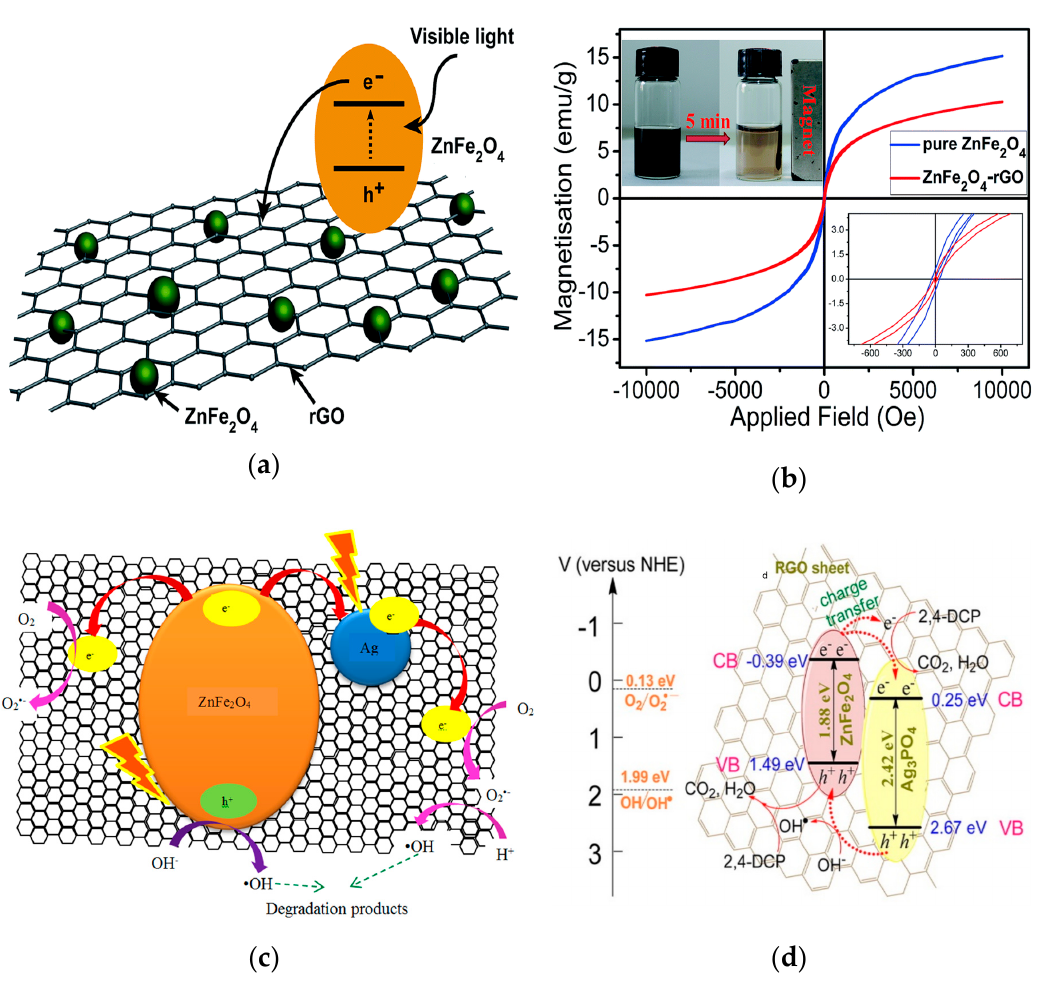
Figure 6. ( a ) Charge transfer route in RGO/ZnFe 2 O 4 ; ( b ) magnetisation curves for pure ZnFe 2 O 4 and RGO/ZnFe 2 O 4 , insert showing magnetic separation of RGO/ZnFe 2 O 4 (Reproduced with permission from [175], Copyright 2014, RSC); charge transfer mechanism in ( c ) ZnFe 2 O 4 –Ag/RGO (Reproduced with permission from [177], Copyright 2016, Wiley) and ( d ) RGO/ZnFe 2 O 4 /Ag 3 PO 4 . (Reproduced with permission from [178], Copyright 2016, ACS.